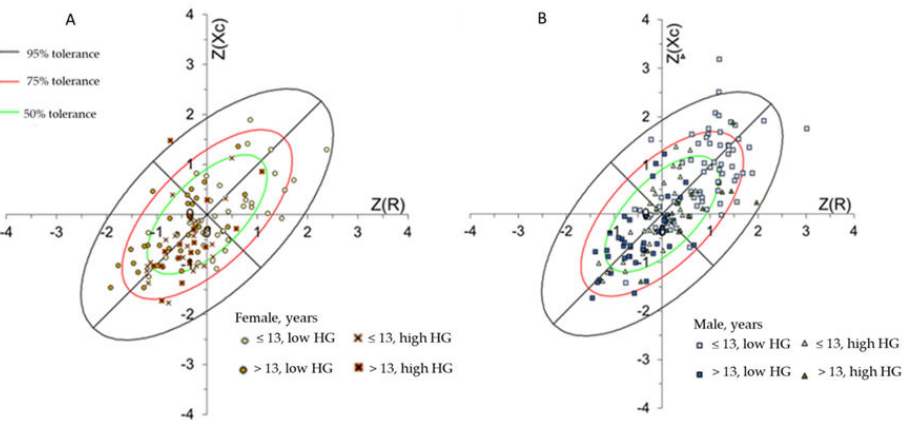
Figure 4. Mean impedance vectors with the 50, 75, and 95% tolerance ellipses for the female ( A ) and male ( B ) adolescent athletes, according to age and handgrip strength